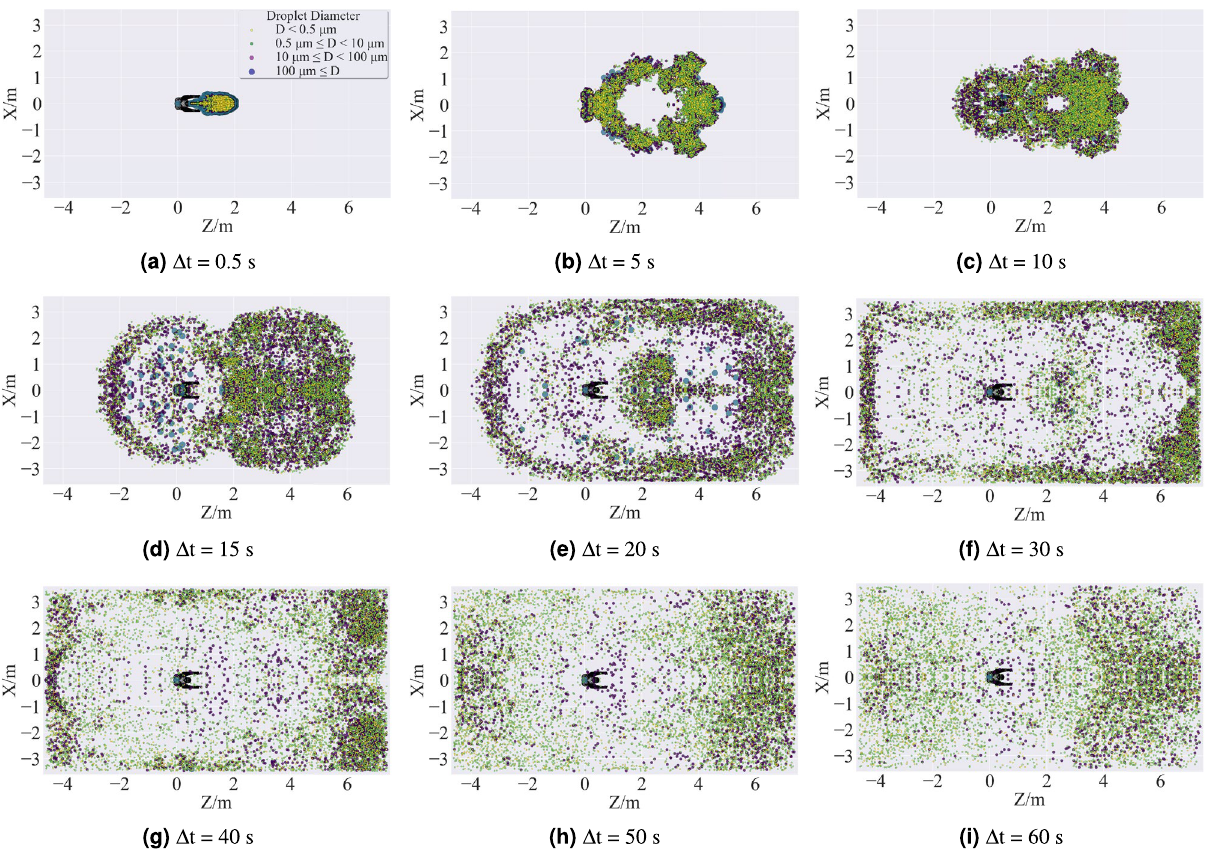
Figure 19. Top view of cumulative time distribution of droplet clouds in Case 1. The distributions of droplets were predicted by using the ANSYS Fluent (version 2019 R2). The figures were drawn by Matplotlib (version